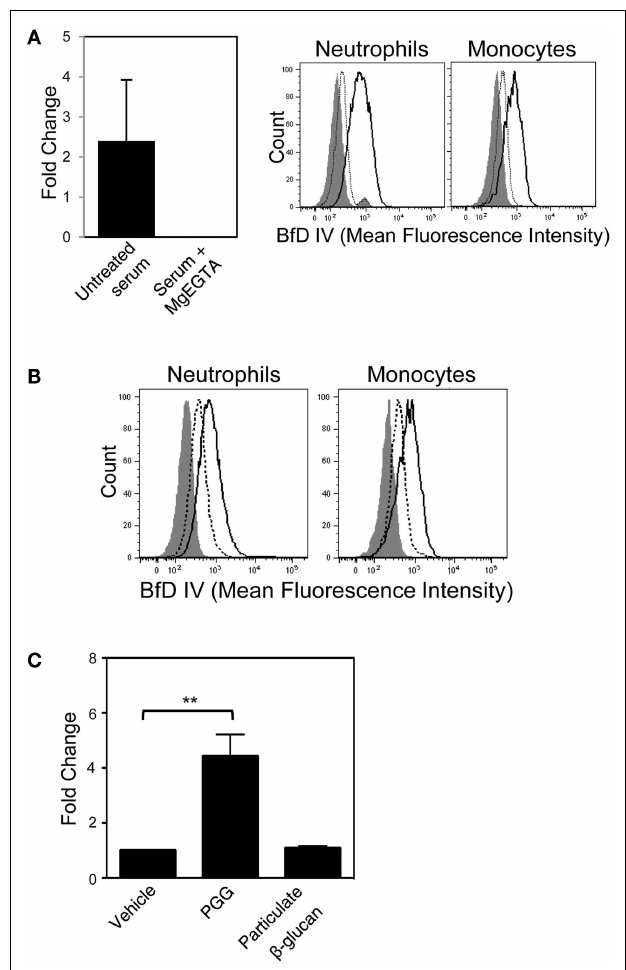
FIGURE 6 | Role of the alternative complement pathway in binding of PGG β -glucan to neutrophils and monocytes . (A) The effect of MgEGTA-treated serum (Mg + EGTA) on iC3b deposition on immobilized PGG β -glucan was measured by ELISA (left), and on OpPGG preparation and subsequent binding to neutrophils and monocytes (right) was measured by flow cytometry. Histograms show binding of OpPGG prepared with untreated serum (solid), OpPGG prepared with MgEGTA-treated serum (dotted) and vehicle binding (gray filled) to neutrophils and monocytes in 10% HI serum. (B) The effect of anti-Factor D Ab, 166-32 on PGG β -glucan binding to neutrophils and monocytes was measured by flow cytometry. Histograms show cell binding to PGG β -glucan in the presence of isotype control (solid) or 166-32 mAb (dotted) in comparison to vehicle-control binding (gray filled). Data shown are representative of three independent experiments with serum from three different donors. (C) Activation of classical or lectin complement pathway as measured by C4a generation upon stimulation ofWB with PGG or particulate β -glucan was determined by ELISA. Bar represent mean fold change values from three independent experiments. ** p ≤ 0.05 compared to